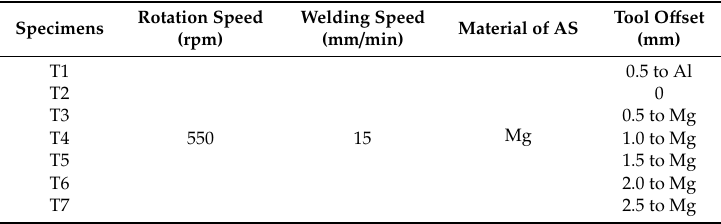
Table 2. Numbered samples with di ff erent tool o ff set.